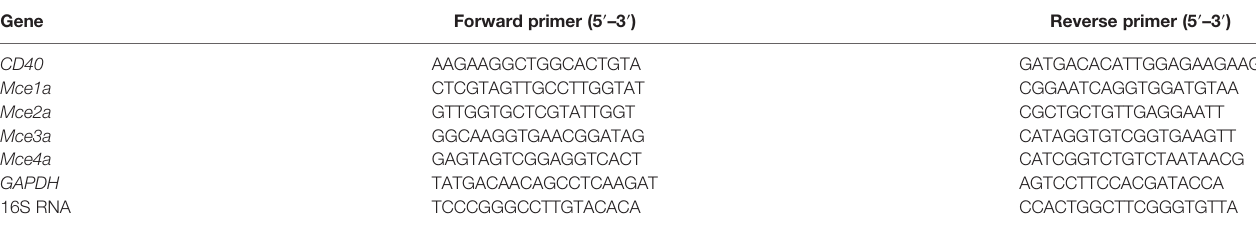
TABLE 2 | Gene-speci fi c primers used in PCR ampli fi